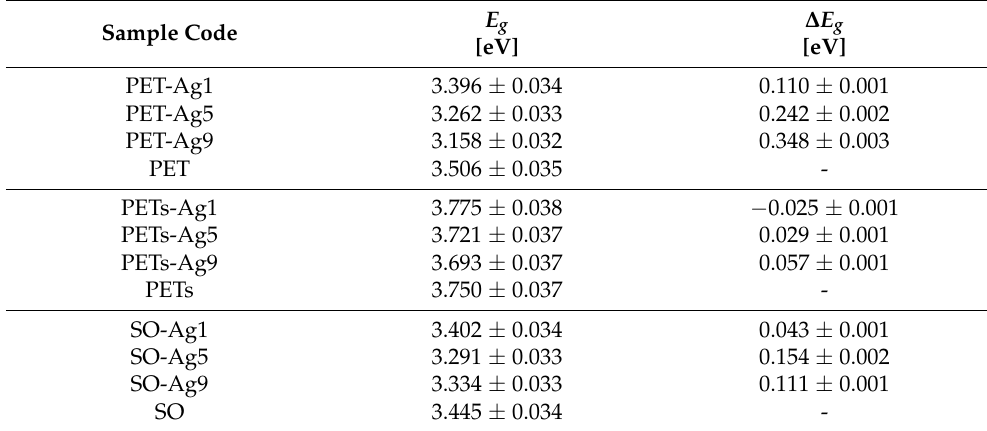
Figure 4. The bandgap graphical determination for ( a ) PET-Ag samples; ( b ) PETs-Ag samples; ( c ) SO-Ag samples; ( d ) substrates. Table 5. The E g values for the chosen samples and